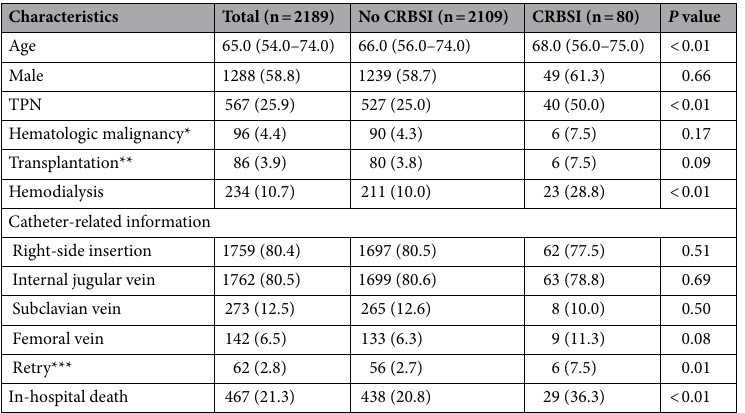
Table 1. Baseline characteristics of the study population. Data are presented as the median (interquartile range) or the frequency (percentage). *Hematologic malignancy included leukemia, lymphoma, myelodysplastic syndrome, and multiple myeloma. **Transplantation included heart, lung, liver, pancreas, and kidney. ***Retry was defined as any insertion trial beyond the first two trials. CRBSI central line-related blood stream infection, TPN total parenteral